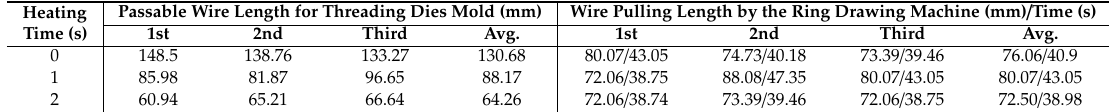
Table 1. Results based on wire pulling speed: k1(1.86 m / s).